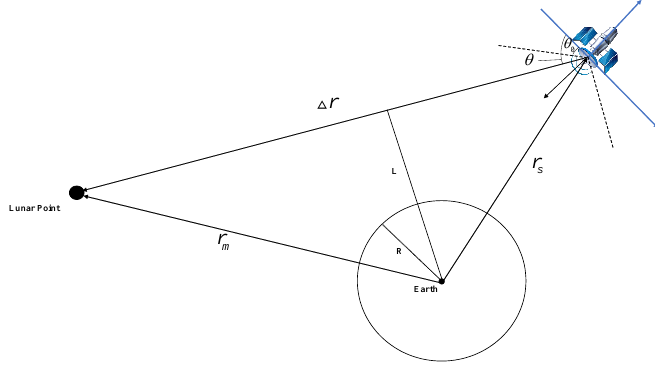
Figure 1. Geometric illustration of satellite-to-lunar visibility.